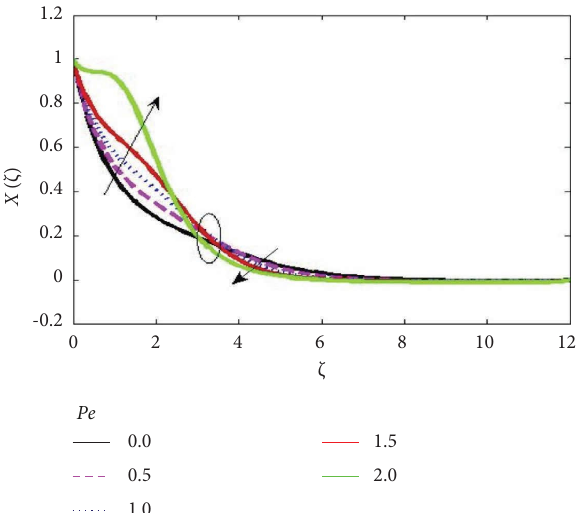
Figure 11: Efect of the Peclet number on the motile density distribution.